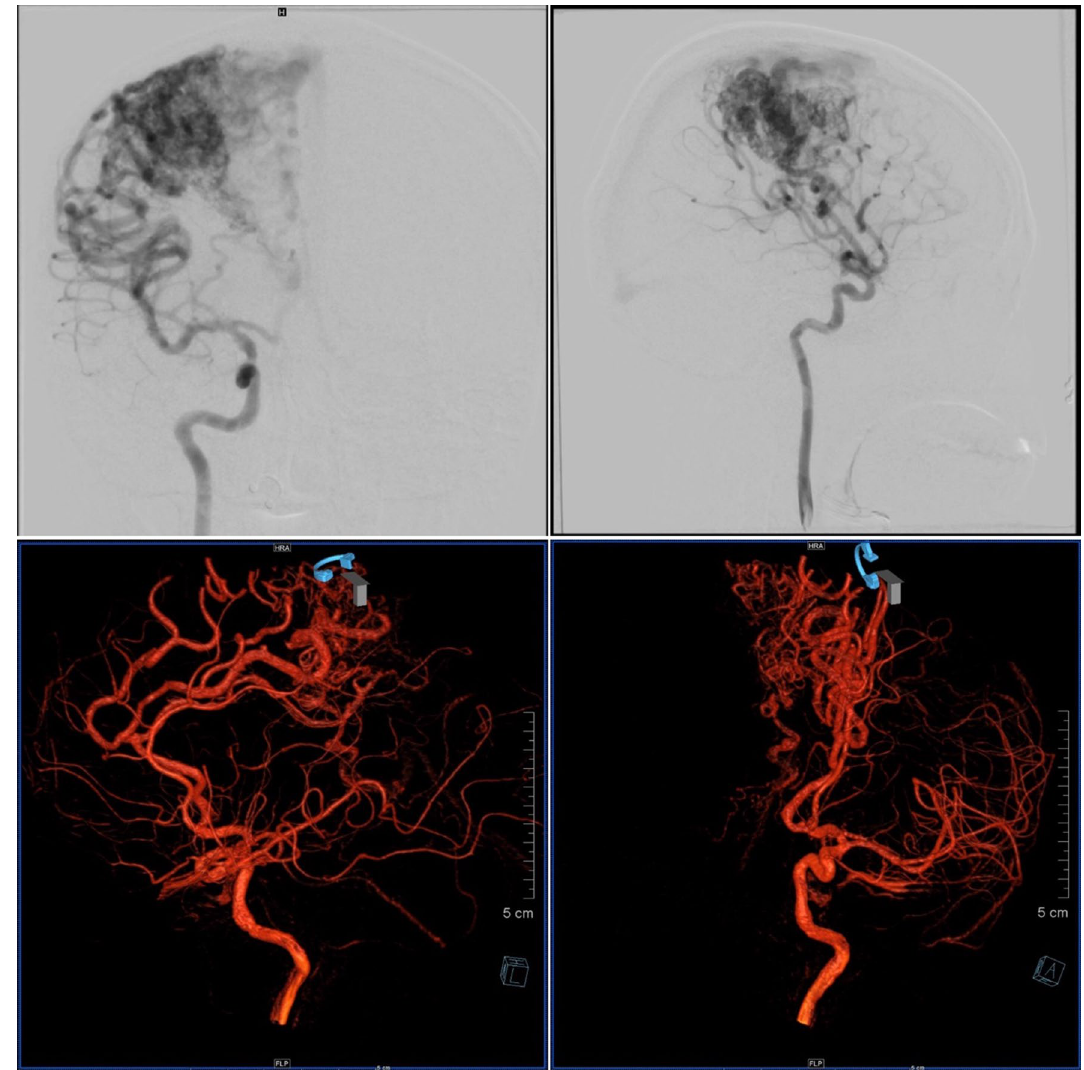
Fig. 4 Digital subtraction angiography (DSA) and volume-rendering technique (VRT) illustration of the high-central, right-sided AVM in right